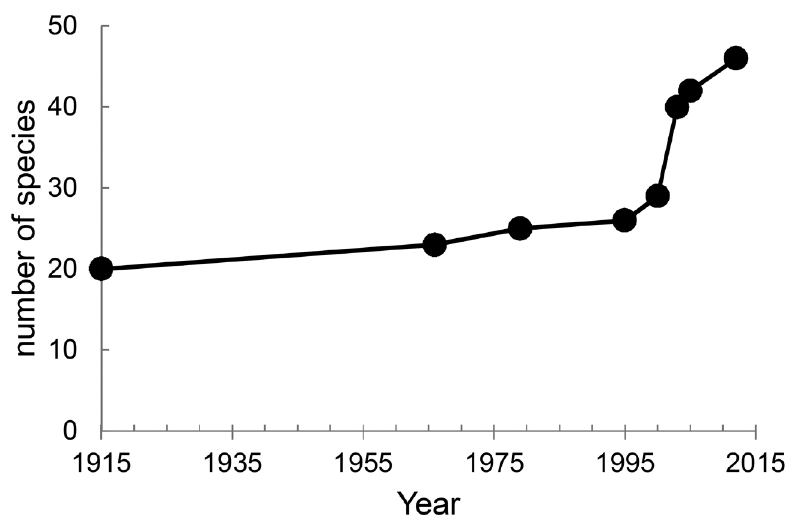
Figure 1. Accumulation of ant species on Lord Howe Island. Note that species considered to be native to the island are all graphed at 1915 irrespective of when they were first